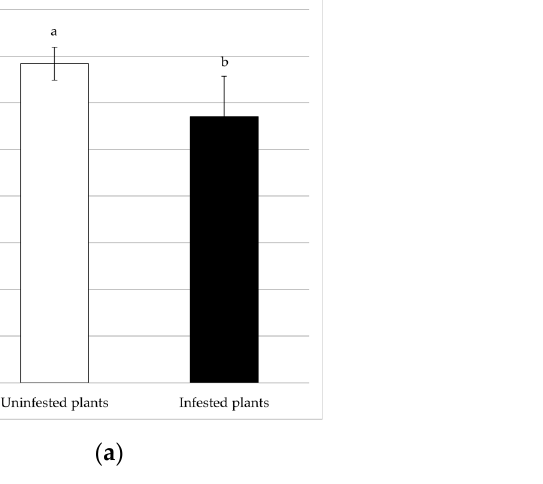
Figure 4. Incidence of B. tabaci infestation on the height ( a ) and shoot dry weight ( b ) of eggplant plants. Different letters indicate statistically significant differences at p < 0.01.